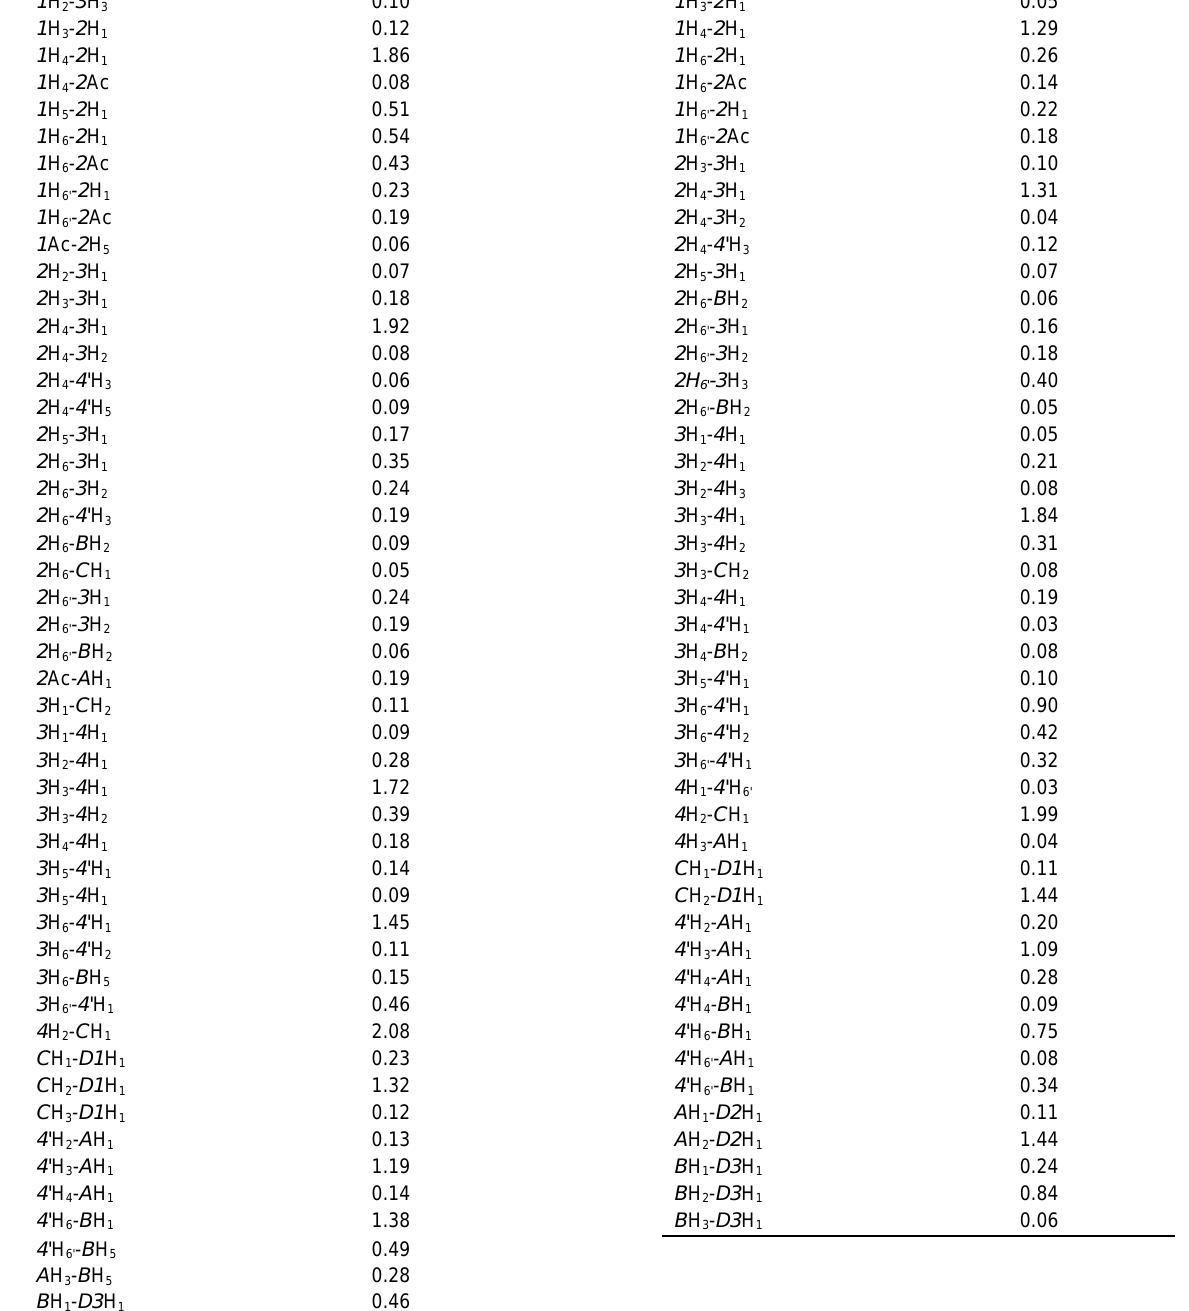
Table S2. Normalized NOE intensities of the interresidue proton pairs of PA-M8B and PA-M9 a . M8B Normalized intensity M9 Normalized